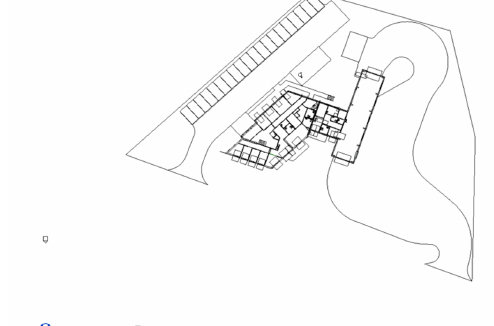
Figure 2. 2D view of the ‘Myran’ IFC model in Autodesk Revit; the blue crossed circle identifies the base point of the model, to which coordinates are